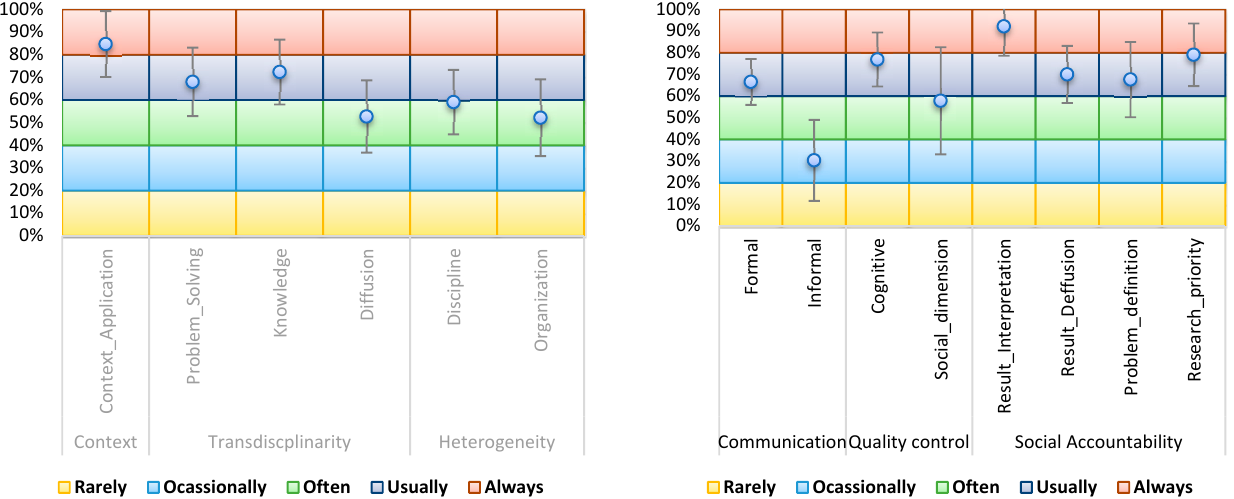
Figure 6. Mode 2 knowledge production features and variables with their corresponding scores with mean deviation from average score.